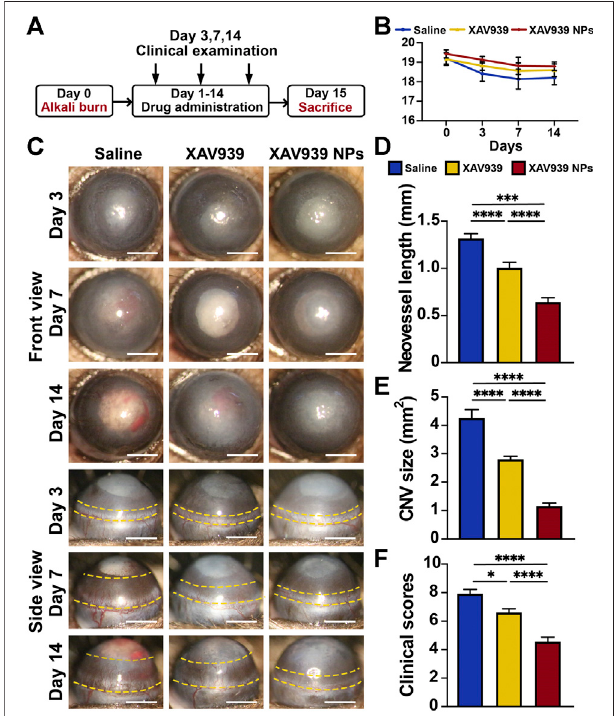
FIGURE 4 | In vivo anti-CNV and corneal wound healing effects. (A) Schematic timeline of the experimental process. (B) Representative front and side images of slit lamp examination on day 3, day 7, and day 14 of the indicated treatments. Yellow dot lines indicate the range of CNV. Scale bar: 1 mm. (C) Mice ’ s weights during the clinical observation of 14 days treatment. Results are presented as the mean ± SEM. n (cid:2) 6. Quanti fi cation of the neovessel length (D) , CNV size (E), and clinical scores (F) on day 14 with indicated treatments. Results are presented as the mean ± SEM. n (cid:2) 6.